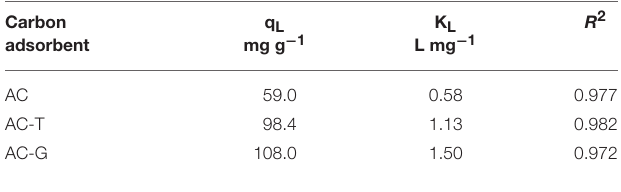
TABLE 3 | Langmuir parameters for the paracetamol adsorption at 25 ◦ C on the different activated carbons. Carbon adsorbent